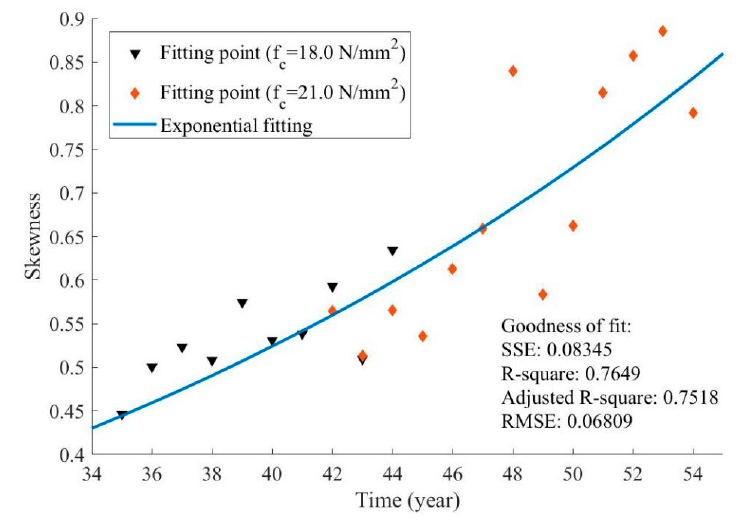
Figure 9. Time-varying skewness.